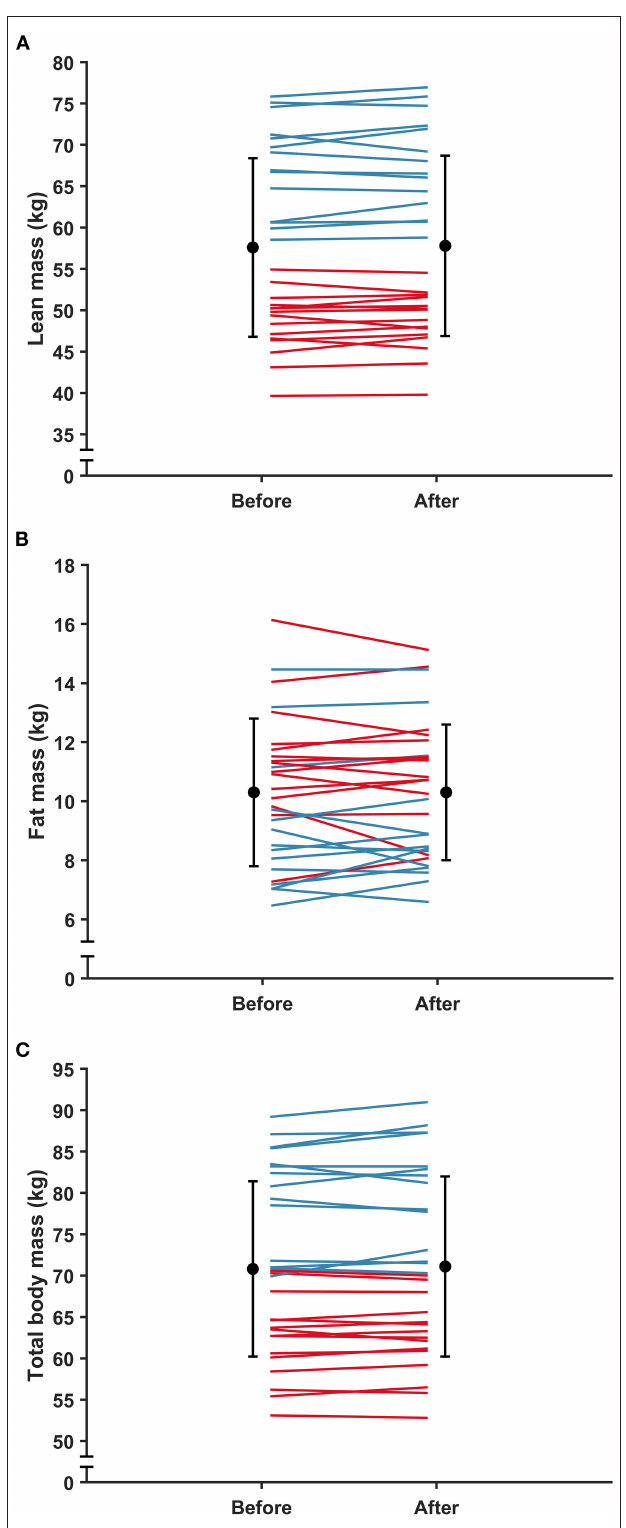
FIGURE 5 | Mean ± SD (A) lean mass; (B) fat mass; and (C) total body mass before and after the training camp. Red lines, women; blue lines,